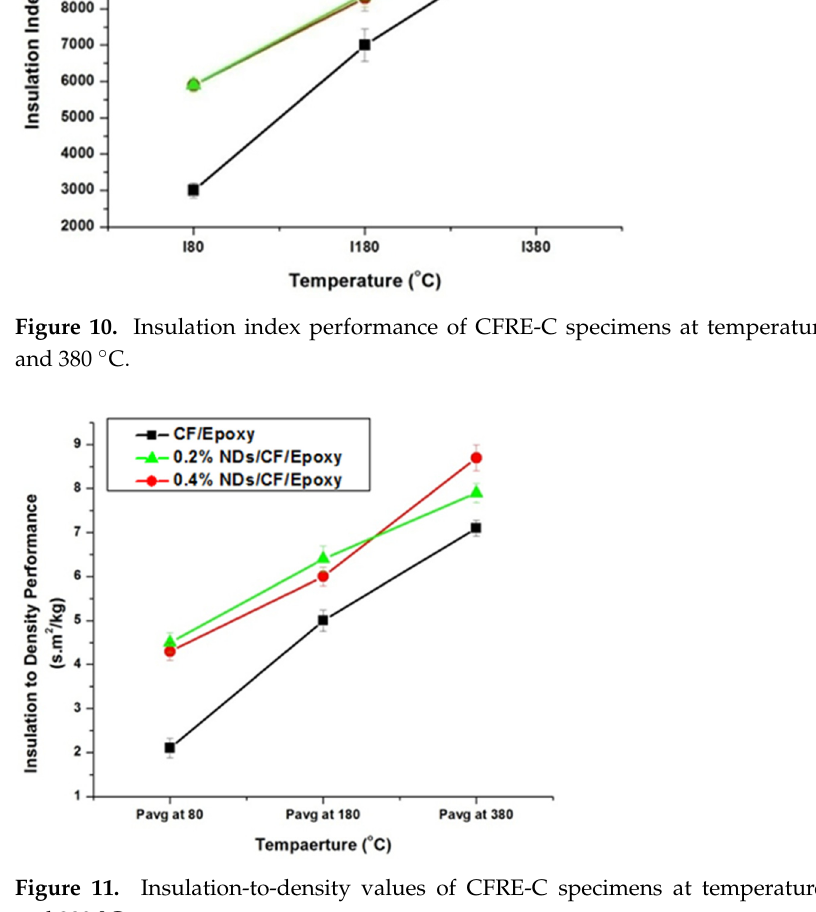
Figure 11. Insulation-to-density values of CFRE-C specimens at temperatures 80 °C, 180 °C, and 380 °C.